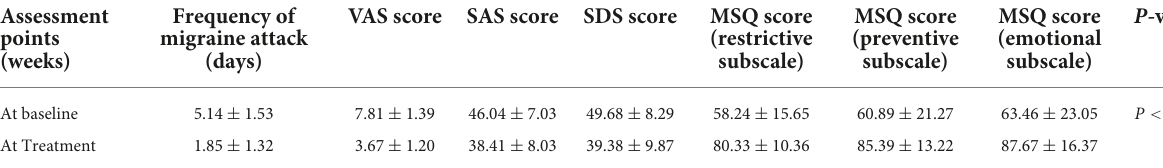
TABLE 3 Clinical outcomes in patients with migraine without aura during the study period ( n = 29).